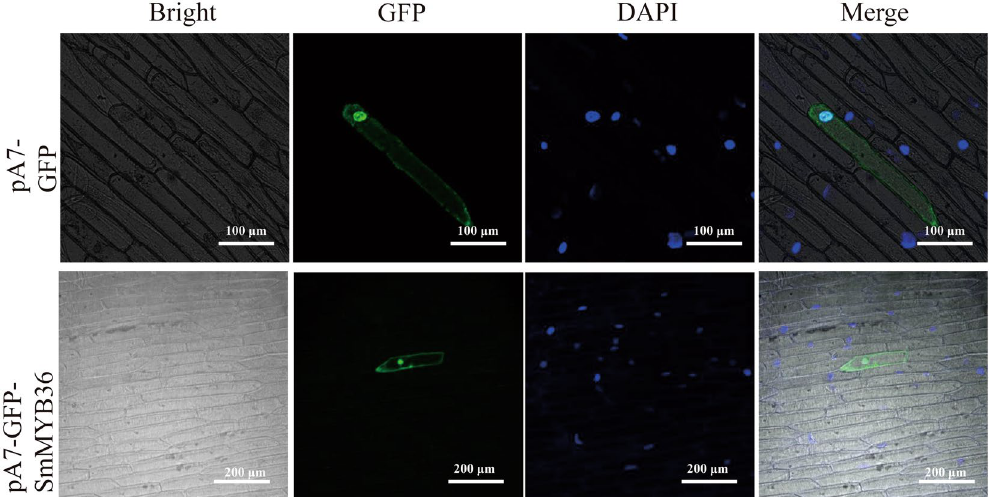
Figure 3. Subcellular localization of SmMYB36 protein. The pA7-GFP (upper lane) and pA7-GFP-SmMYB36 (bottom lane) plasmids were transiently expressed in onion epidermal cells. Fluorescence was observed using a confocal laser scanning microscope at 24 h after incubation. The pictures show bright field, green fluorescent field, DAPI and overlay of three fields from left to